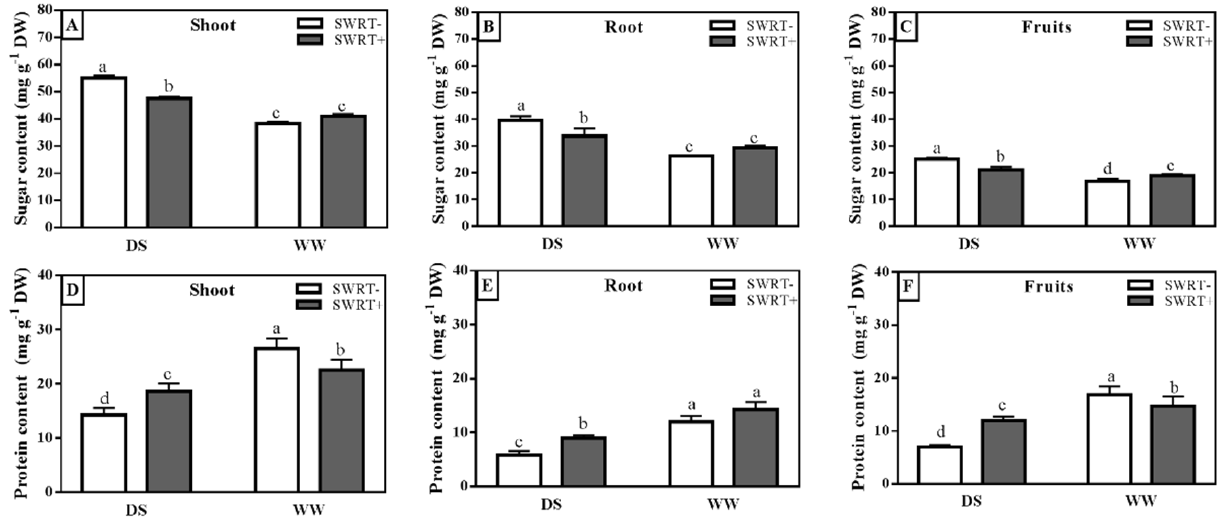
Figure 1. Effects of water regimes (DS: drought stress or WW: well-watered) on shoot, root, and fruit ( A – C ) total soluble sugar content, and ( D – F ) protein content subjected to treatments. SWRT − : without subsurface water retention technology (SWRT); SWRT+: with SWRT. Data represented are mean of three replicates ± standard error (SE) (n = 3). Different letters in the same column show significant difference at p < 0.05.